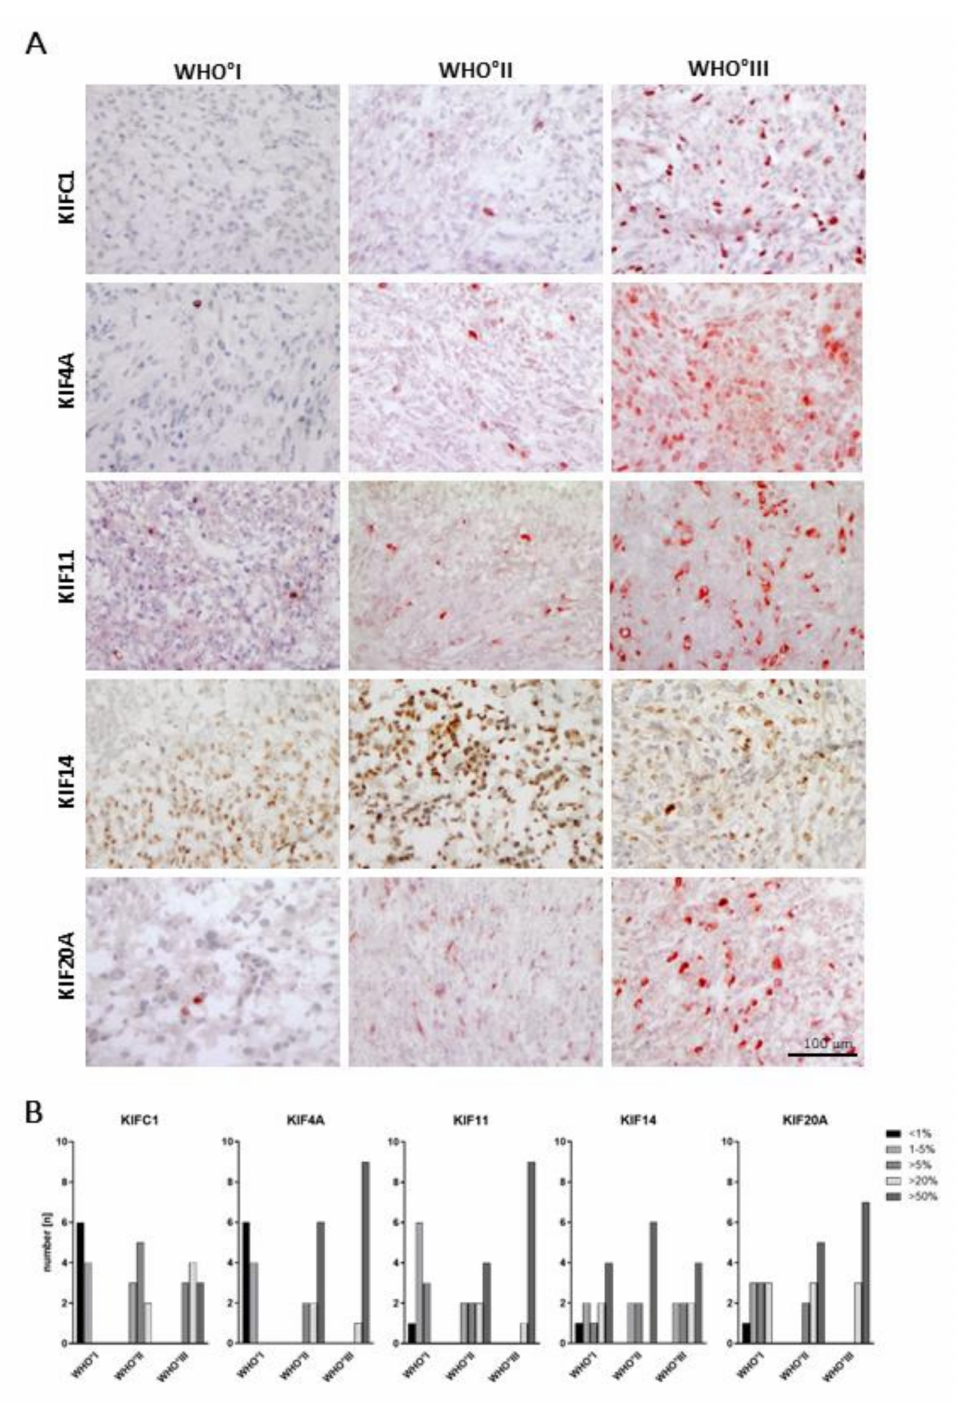
Figure 2. Immunohistochemical staining of meningioma tissue samples reveals a WHO grade-specific increase of protein levels. ( A ) Representative immunohistochemical stainings are shown for KIFC1, KIF4A, KIF14 and KIF20A and each WHO grade. Ten meningioma tissue samples of each WHO grade were stained with antibodies against KIFC1, KIF4A, KIF11, KIF14, or KIF20A. ( B ) Staining was evaluated as percent positive cells in five categories ( < 1%, 1–5%, > 5%, > 20% and > 50% positive